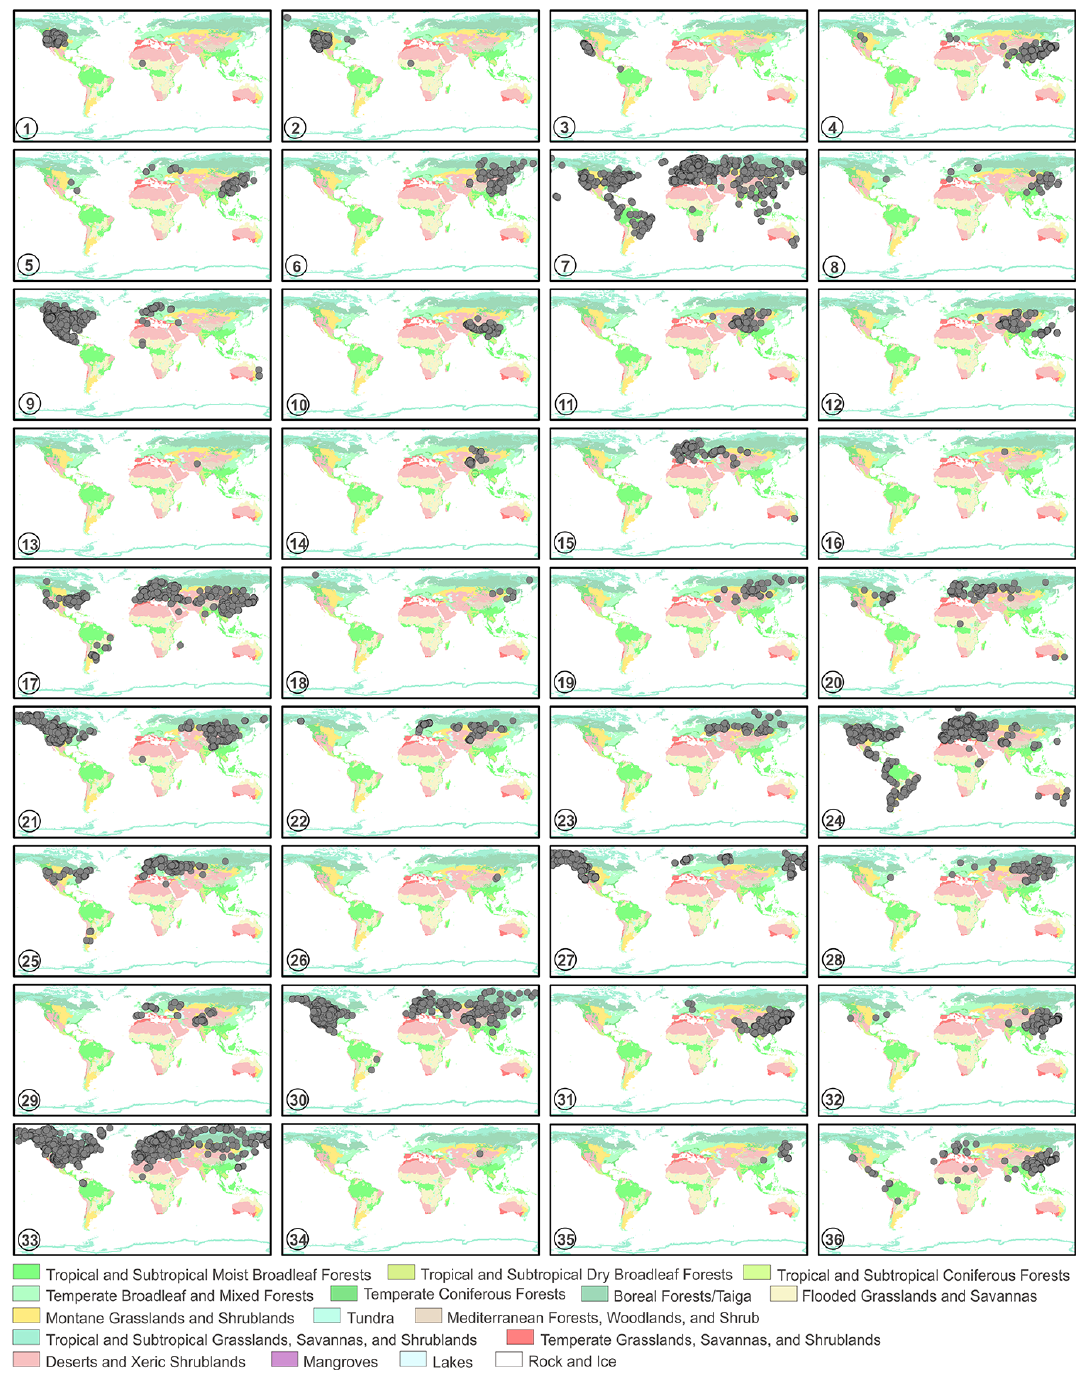
Figure 16. The global distribution maps of 36 sampled taxa in terrestrial biomes (modified from Olson et al., 2001). 1. Artemisia cana